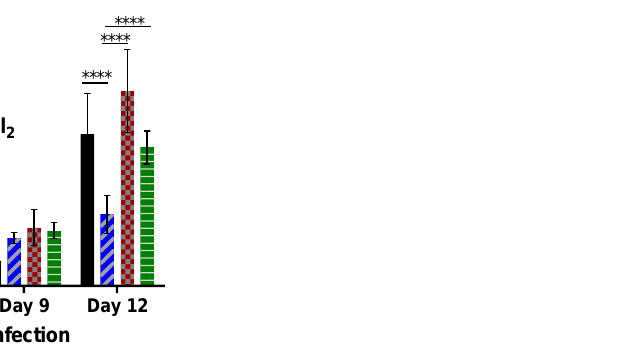
Figure 4. ctpB is required for replication and copper acquisition by M. tuberculosis in adipocytes. 3T3-L1 adipocytes were infected for 24 h at MOI = 1 while the indicated strains were cultured in DMEM-FBS (basal medium, BM) or BM supplemented with 0.1 mM CuCl 2 . At the indicated time-points, cells were lysed with 1% Triton X-100 and viable bacteria were enumerated by plating on 7H10tgADS agar. Results shown are the averages with standard error from two experiments performed in triplicate. ANOVA with multiple comparisons between groups was used to assess significant differences between groups (**** p < 0.0001).